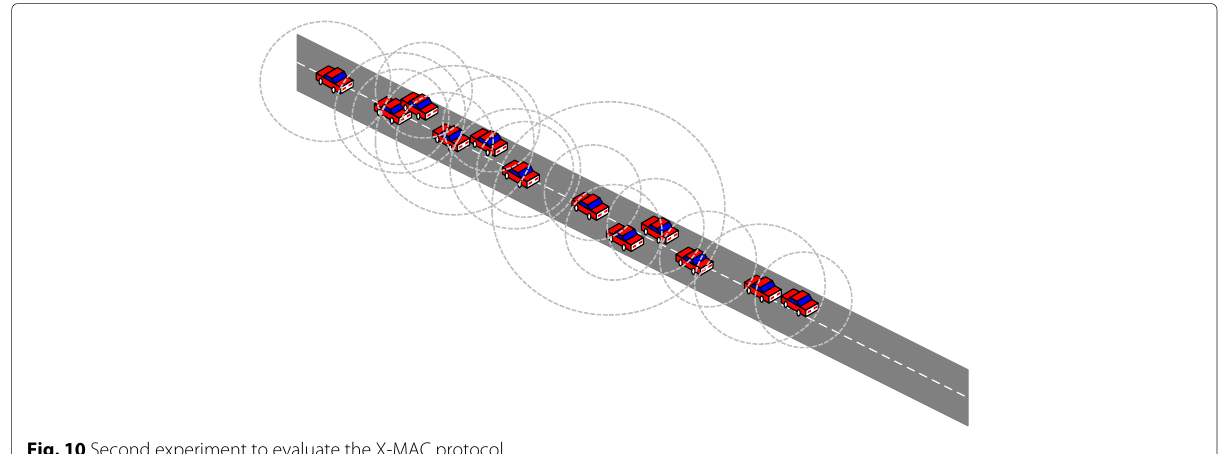
Fig. 10 Second experiment to evaluate the X-MAC